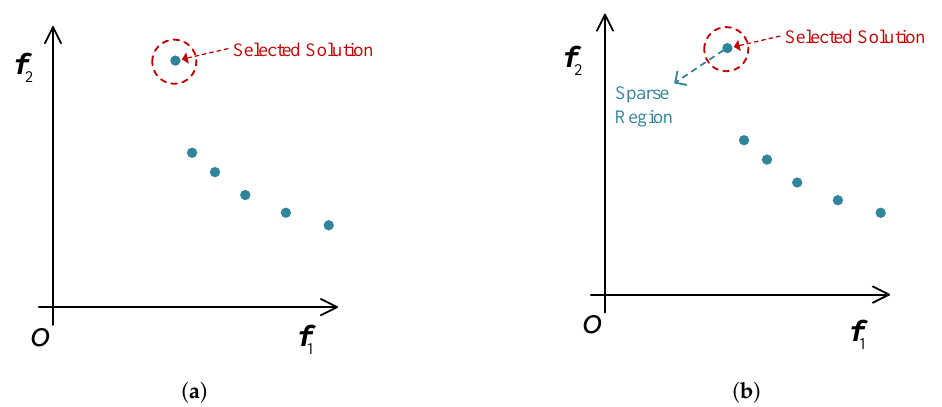
Figure 1. An illustrative example of the local search. ( a ) select a solution with good diversity, ( b ) explore the sparse region by the local